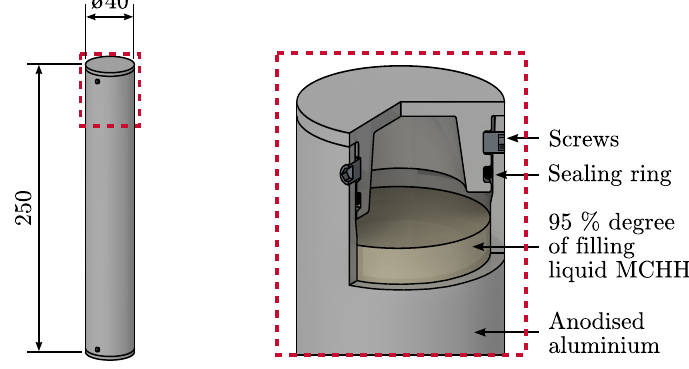
Figure 6. Final encapsulation concept, consisting of seamless aluminium pipes as base material.